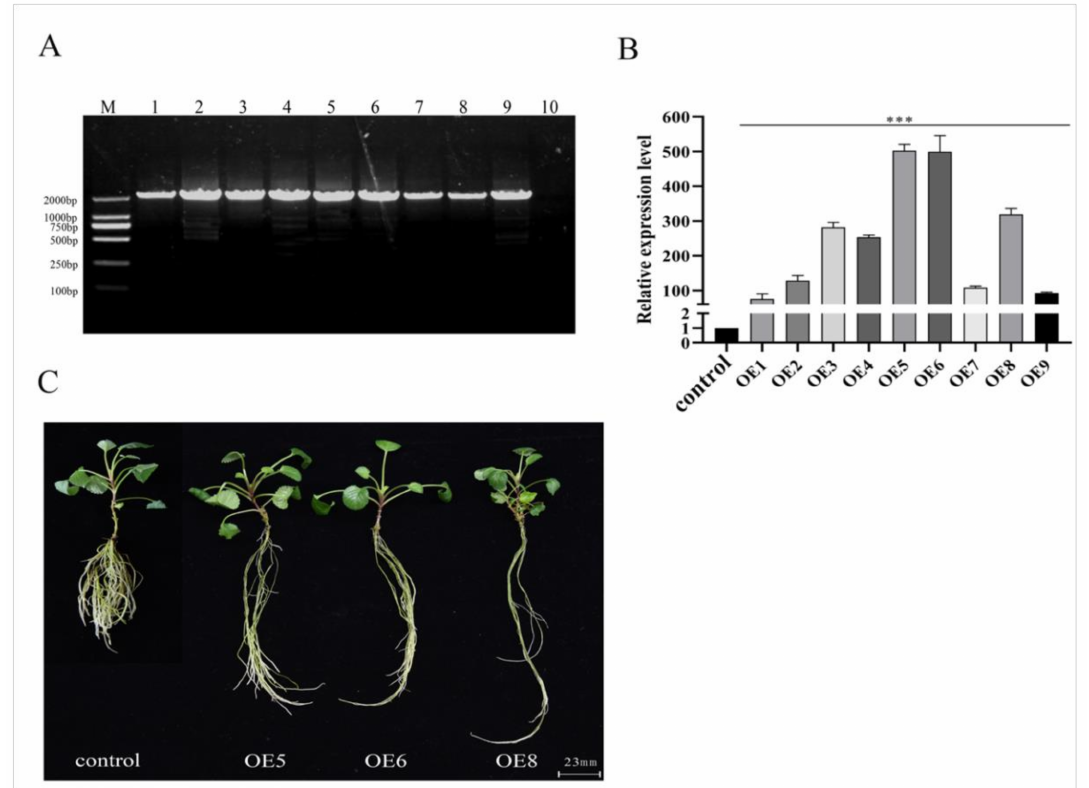
Figure 4. Identification and phenotype of the SmSPL6 -overexpressed transgenic Salvia miltiorrhiza . ( A ) PCR-amplification product from the genome DNA of transgenic lines and the control. Forward primer: CaMV35S –F, reverse primer: SmSPL6 –R, full length: 1833 bp. Lanes M, DL2000 DNA marker; 1–9, different transgenic lines; 10, control line obtained by plant tissue culture without Agrobacterium infection. ( B ) qRT-PCR analysis. Fold changes reflect the expressions of transgenic lines compared with the control expression, where the control values were set to 1. All data are the means of three replicates, with error bars indicating SD; *** represents a significant difference at p < 0.01 in contrast to the control. ( C ) Phenotype of the SmSPL6 -overexpressed OE5, OE6, and OE8 transgenic lines and the control. Table 2. Root parameters of the SmSPL6 overexpressed (OEs) transgenic lines and the control. Lines Roots